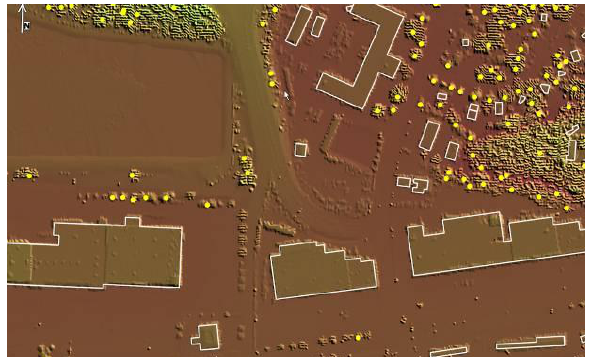
Figure 7. Extraction of buildings in flat areas